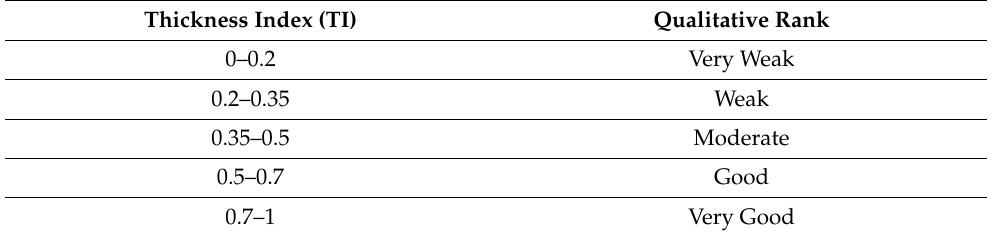
Table A2. Geomechanical units based on Containment Index (CI).